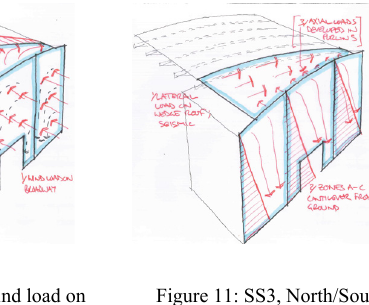
Figure 8: Structural zones within the wedge. Zone A : 3No. adjacent full height splice-laminated glass panels mechanically stitched together form a vertical cantilever in the facade plane; full height fins span from ground to purlins in zone F; bolted to ground slab; Zone B : 4No. adjacent full height splice-laminated panels mechanically stitched together form a portal frame over the doorway; full height fins span from ground to roof; bolted to ground slab; Zone C : 3No. adjacent full height splice-laminated panels mechanically stitched together form a vertical cantilever in the facade plane; full height fins span from ground to purlins in zone F; bolted to ground slab; Zone D : 5No. adjacent full height splice-laminated panels mechanically stitched together form a vertical cantilever in the facade plane; full height fins span from ground to zone E; Zone E : 1No. splice-laminated cold-bent panel spans as a beam between stone parapet and zone A, resist wind load applied to zone D; Zone F : 8No. splice-laminated cold-bent panels mechanically stitched together form a horizontal beam spanning 60’ between parapets, resist wind load applied to zones A, B, C. Zone G : single infill panel – no structural function. A preliminary stick model of global behaviour is shown on the right.